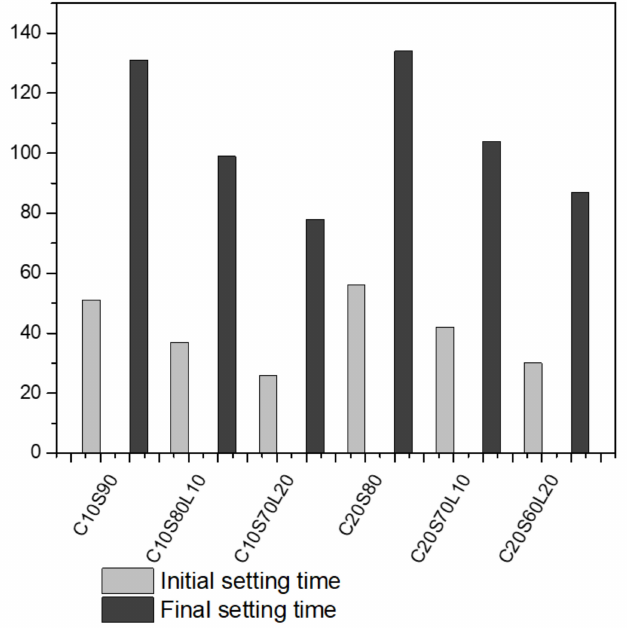
Figure 4. Initial and final setting time of alkali-activated slag (AAS)